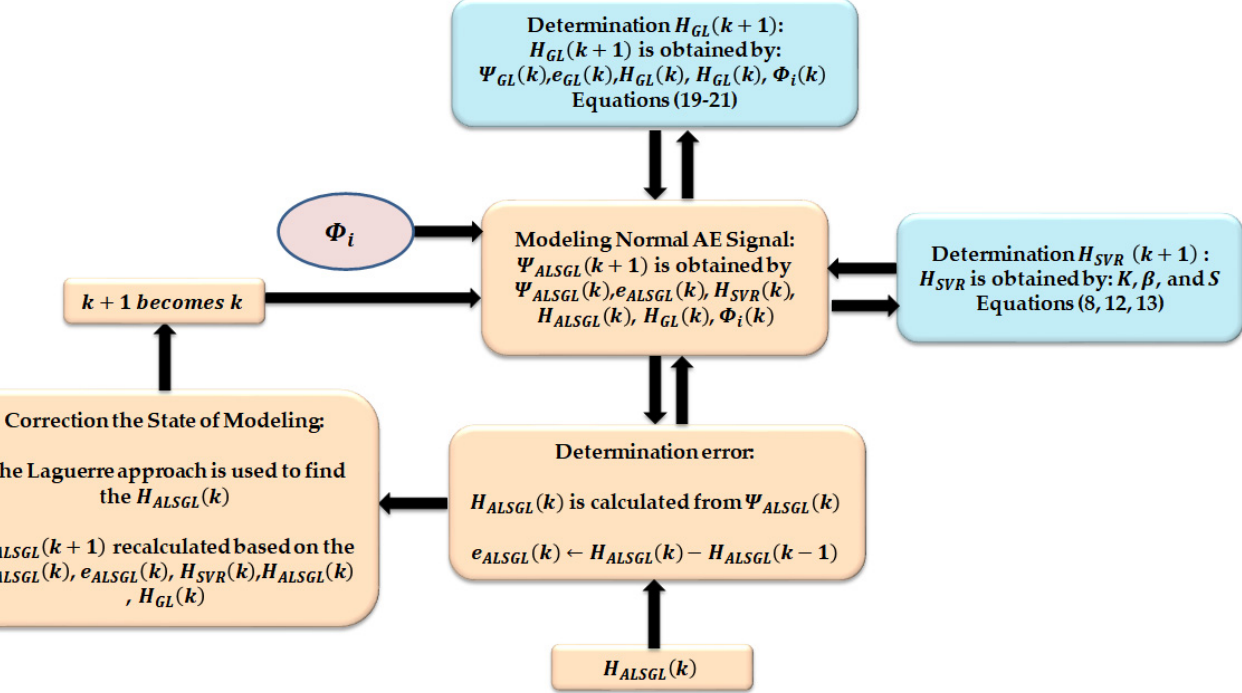
Figure 5. Flow chart typical of AE signal modeling using ALS-GL approach.